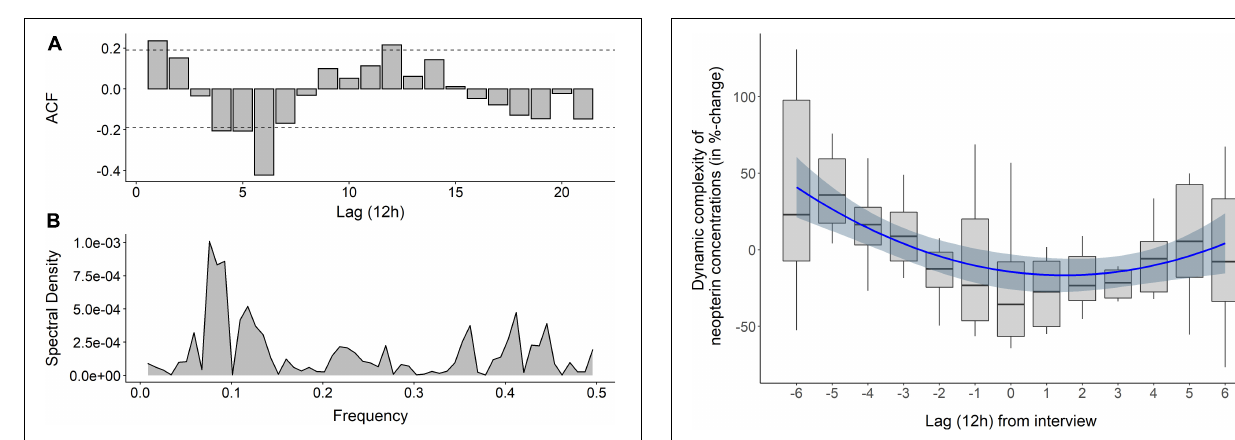
FIGURE 3 | Superposed epoch analysis (SEA) of in-depth interviews ( n = 8) and Dynamic Complexity (DC) of urinary neopterin levels, expressed as change in percentage of the arithmetic mean, during a window of ± 6 lags (12 h), i.e., 3 days before and after interviews. Boxplots represent median (horizontal lines), quartiles (boxes), and range (vertical lines) of neopterin DC values at given lags. Interviews took place at lag 0. A polynomial curve with a linear and a quadratic estimator was fitted to the data (blue line with blue shaded standard